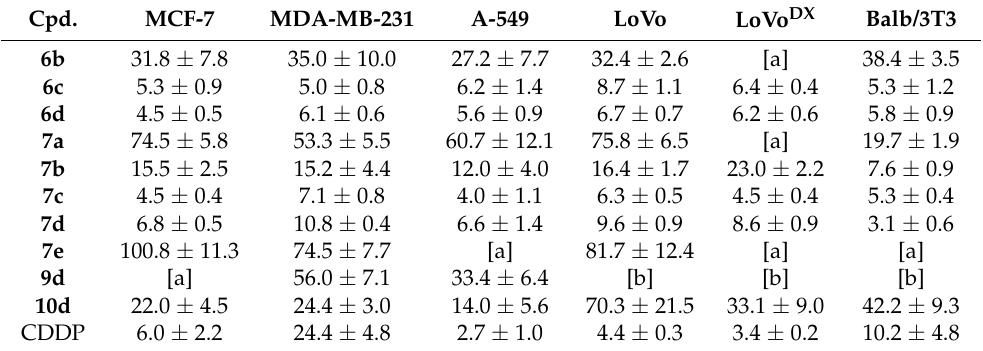
Table 3. Antiproliferative activity of compounds 6 , 7 , 9 and 10 on five human cancer cell lines and non-tumorigenic line Balb/3T3 given as IC 50 ± SD ( µ M), with cisplatin (CDDP) used as reference. Cpd.